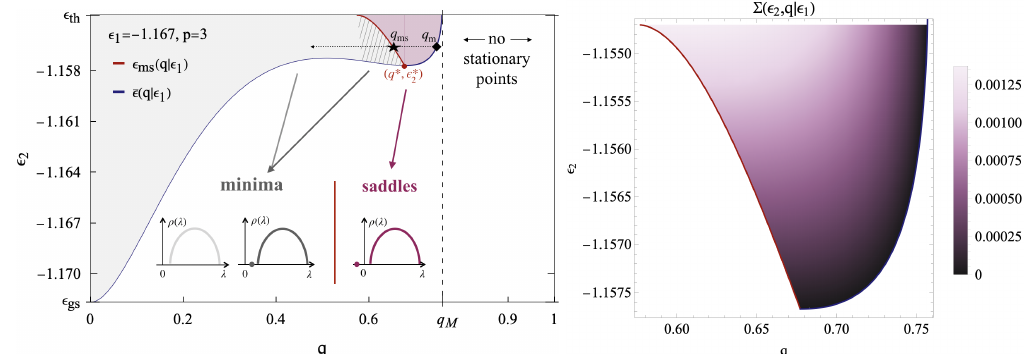
Figure 2: Left. The colored regions identify the range of energy densities ε stationary points found at overlap q with a minimum of energy density ε the violet area corresponds to index-1 saddles, the gray one to minima that are either correlated (dashed area) or uncorrelated to the reference one. The eigenvalue den- sity ρ ( λ ) of the Hessian matrices at the stationary points is sketched at the bottom of the plot. Right. Color plot of the complexity of the index-1 saddles as a function of their energy and overlap q with the reference minimum of energy ε